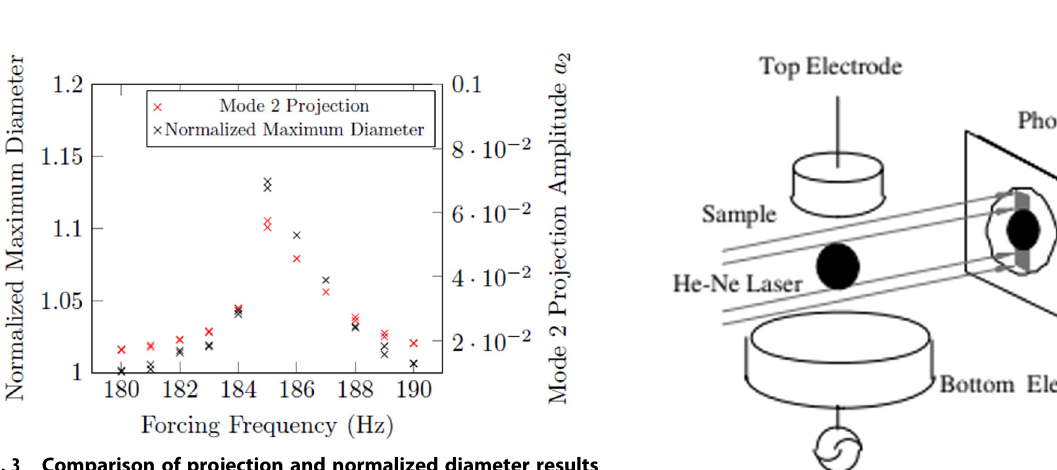
Fig. 3 Comparison of projection and normalized diameter results for the Faraday forcing method on mode 2 resonance. Sample is 35.027 mg Zirconium at 1800 ∘ C .